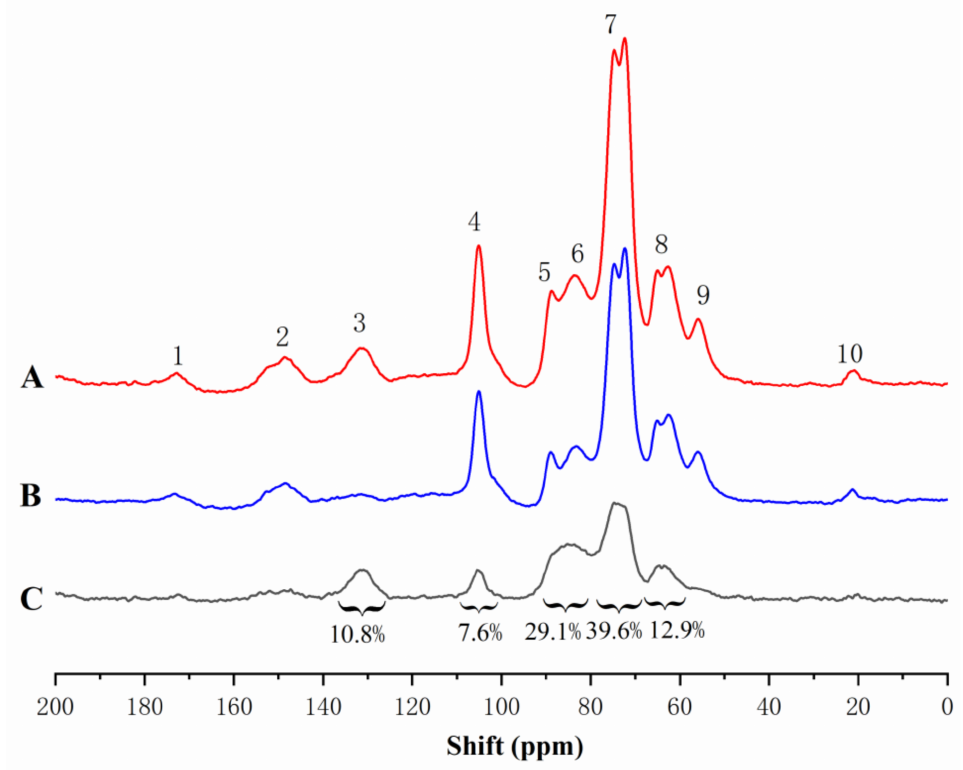
Figure 2. Solid-state CP/MAS 13 C-NMR spectra of Ginkgo CW-DHP: ( A ) 13 C- 2 H-enriched ginkgo CW-DHP; ( B ) unenriched ginkgo CW-DHP; and ( C ) difference spectrum obtained by subtracting spectra ( B ) from spectra ( A ). Table 3. Assignment of signals of CP/MAS 13 C-NMR difference spectrum of Ginkgo CW-DHP. Shift ( δ ,